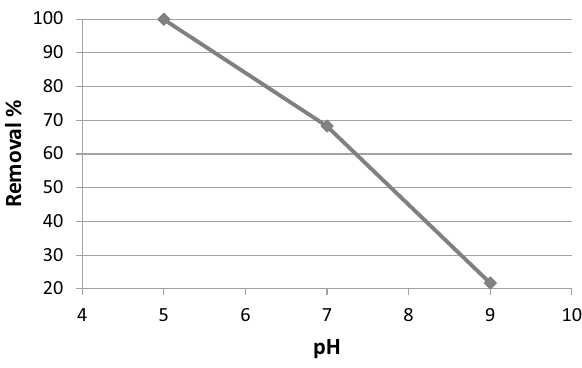
Fig. 9 pH versus removal (%) by Aspergillus niger